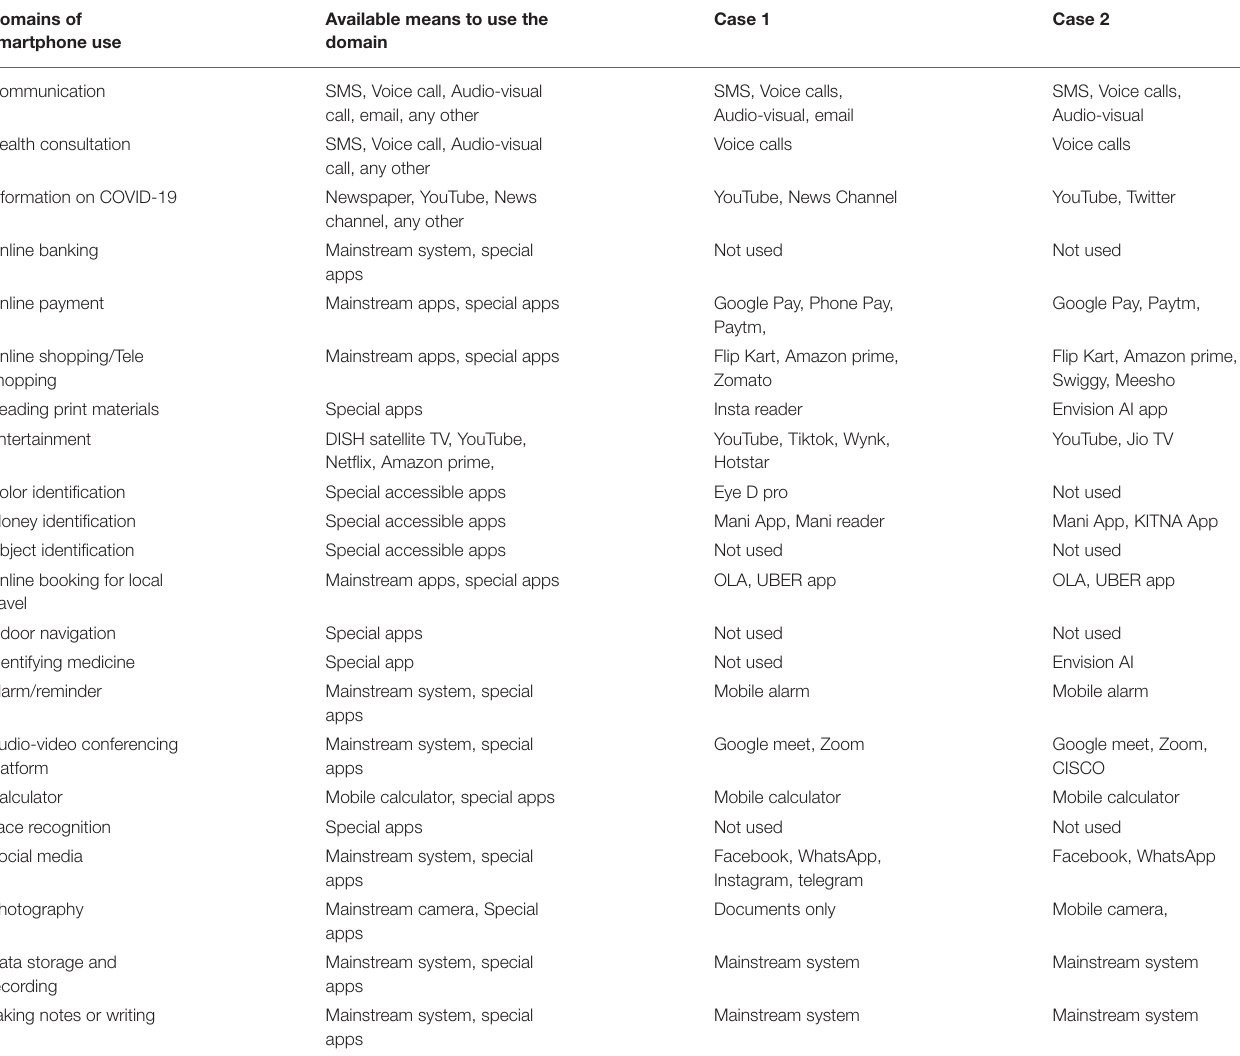
TABLE 1 | Domains of smartphone use by person with profound visual